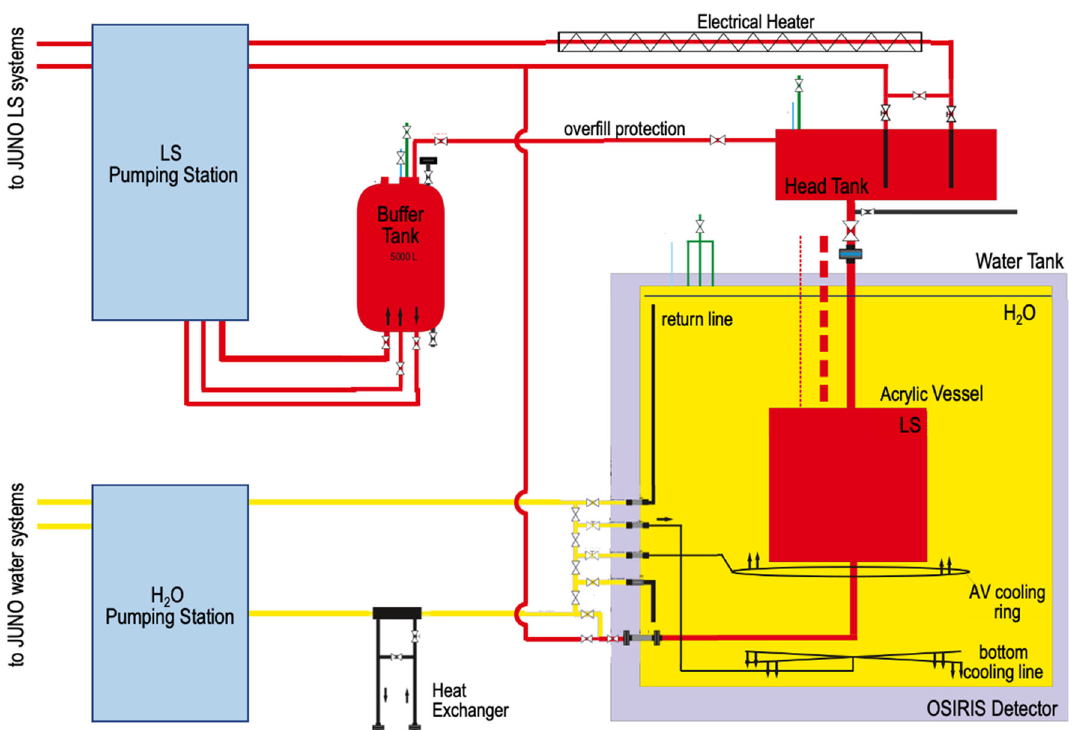
Fig. 5 Conceptual layout of the OSIRIS LHS. The LS system (red) includes a pumping station, buffer tank and head tank that permit the continuous exchange of the LS within the Acrylic Vessel. An electric heating system permits to pre-warm the LS to establish a temperature